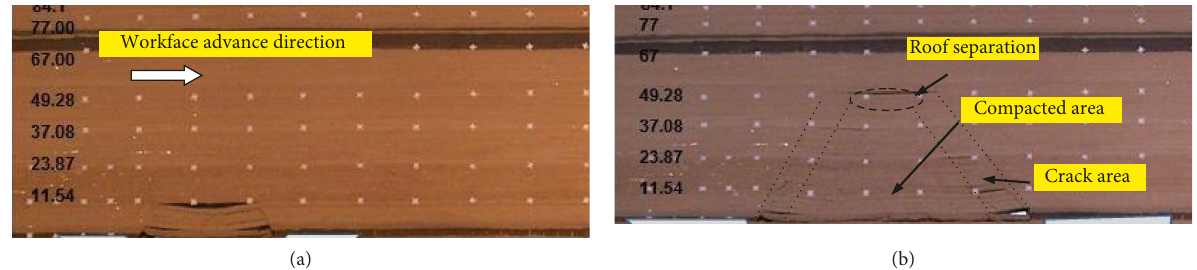
Figure 4: The roof activity law of different workface advance distances: (a) 50cm; (b) 100cm.